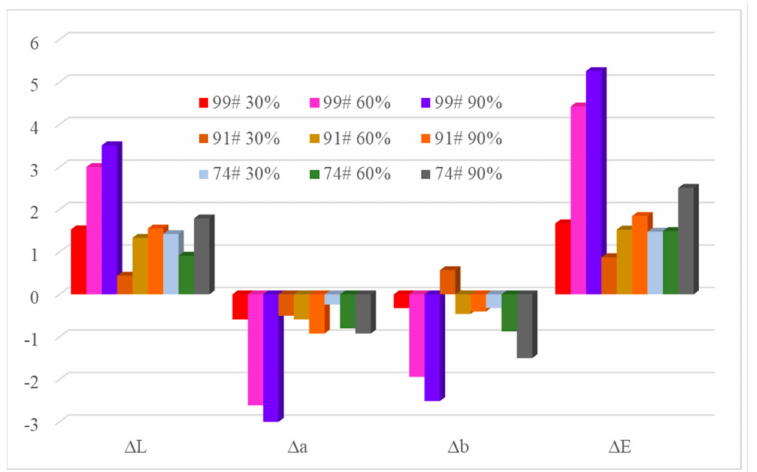
Figure 4. Change in L, a, and b and total color change ( ∆ E) in samples after corrosion